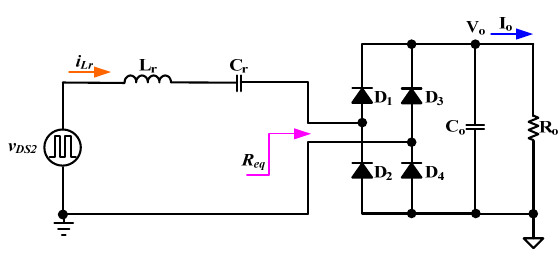
Figure 6. Equivalent circuit during the design of the series resonant tank.